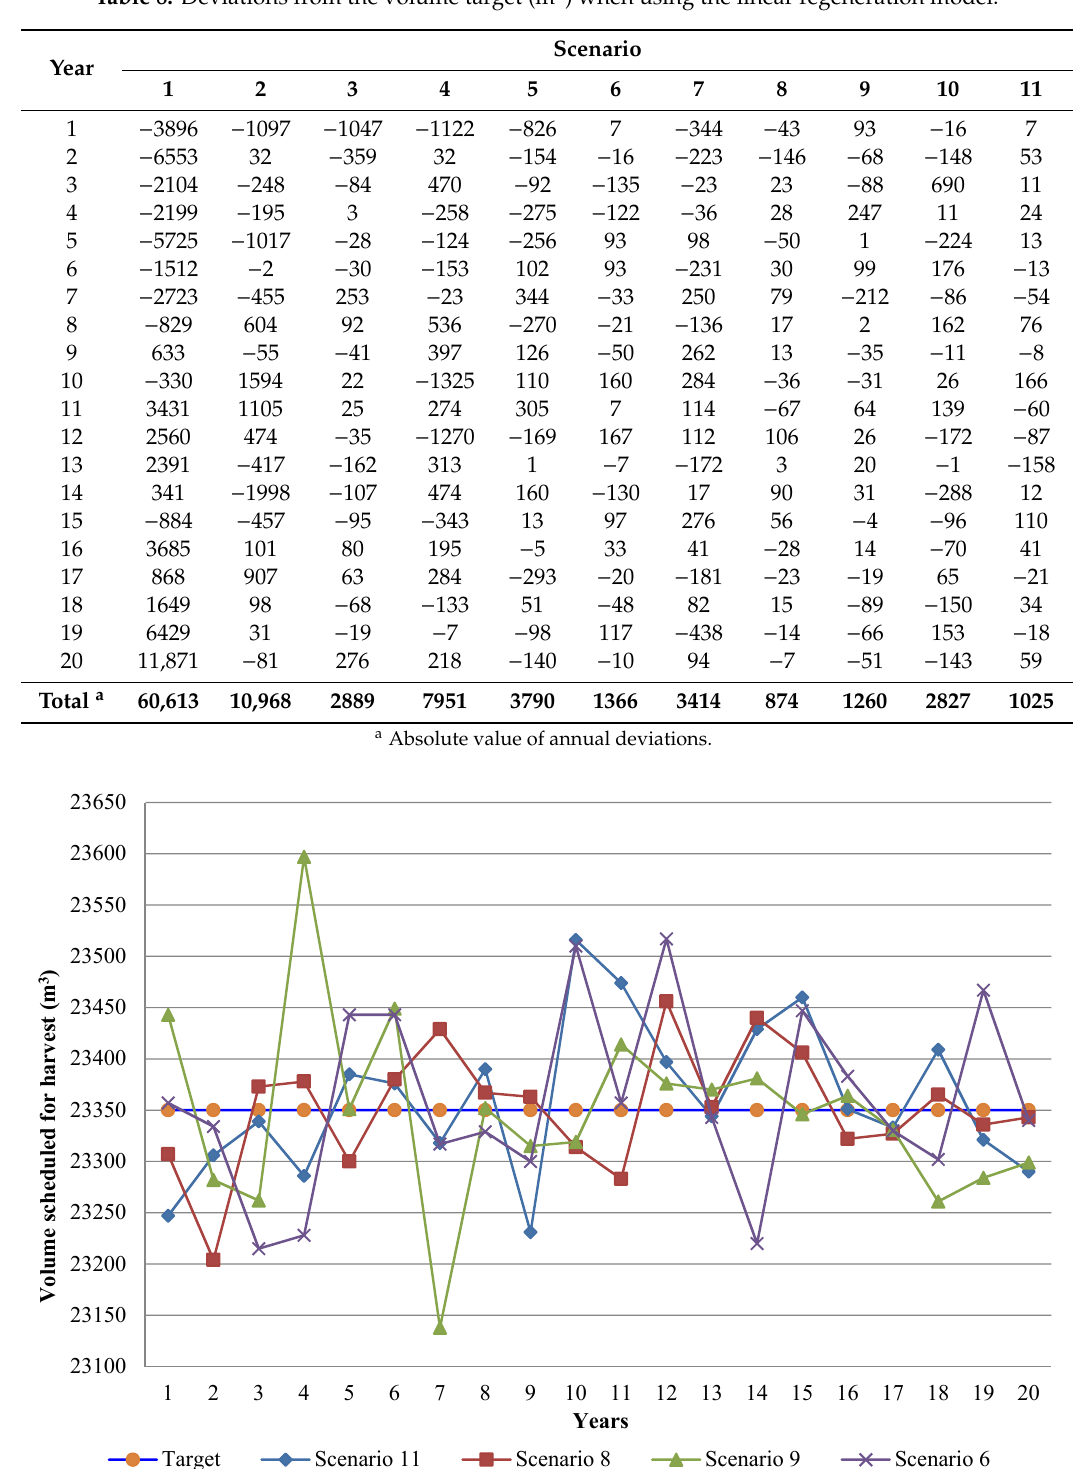
Table 8. Deviations from the volume target (m 3 ) when using the linear regeneration model.